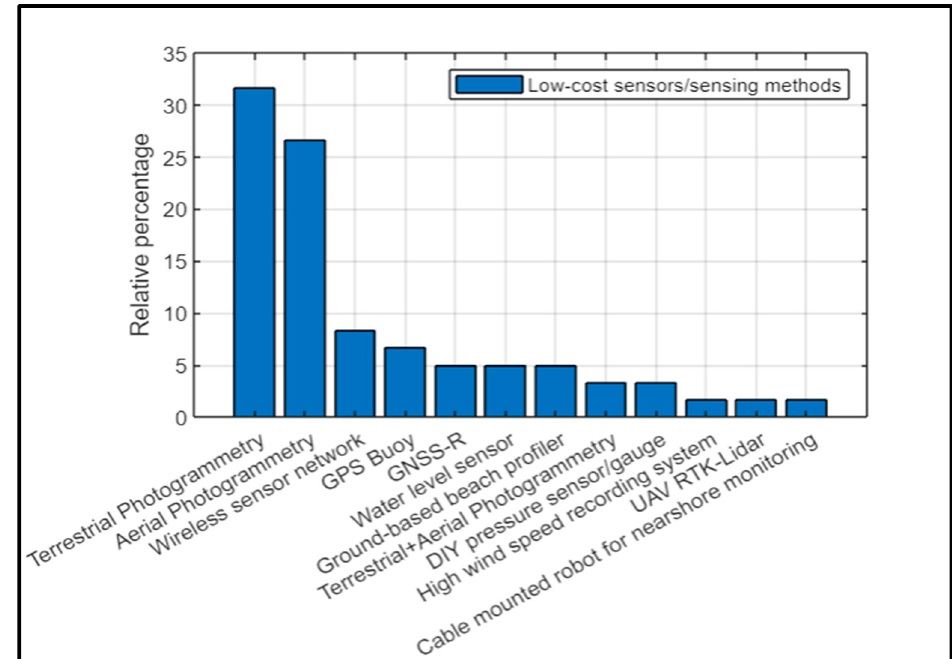
Figure 2. Percentage of the low-cost sensors/sensing methods.